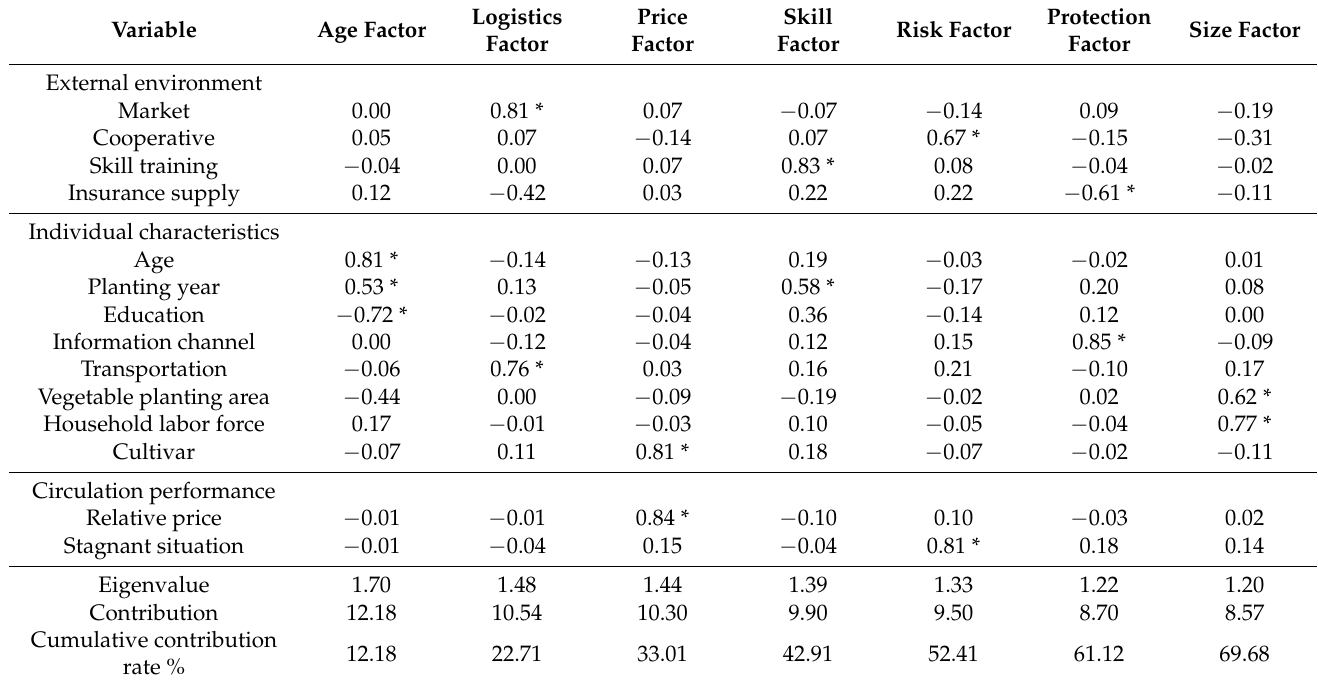
Table 3. Factor analysis results of